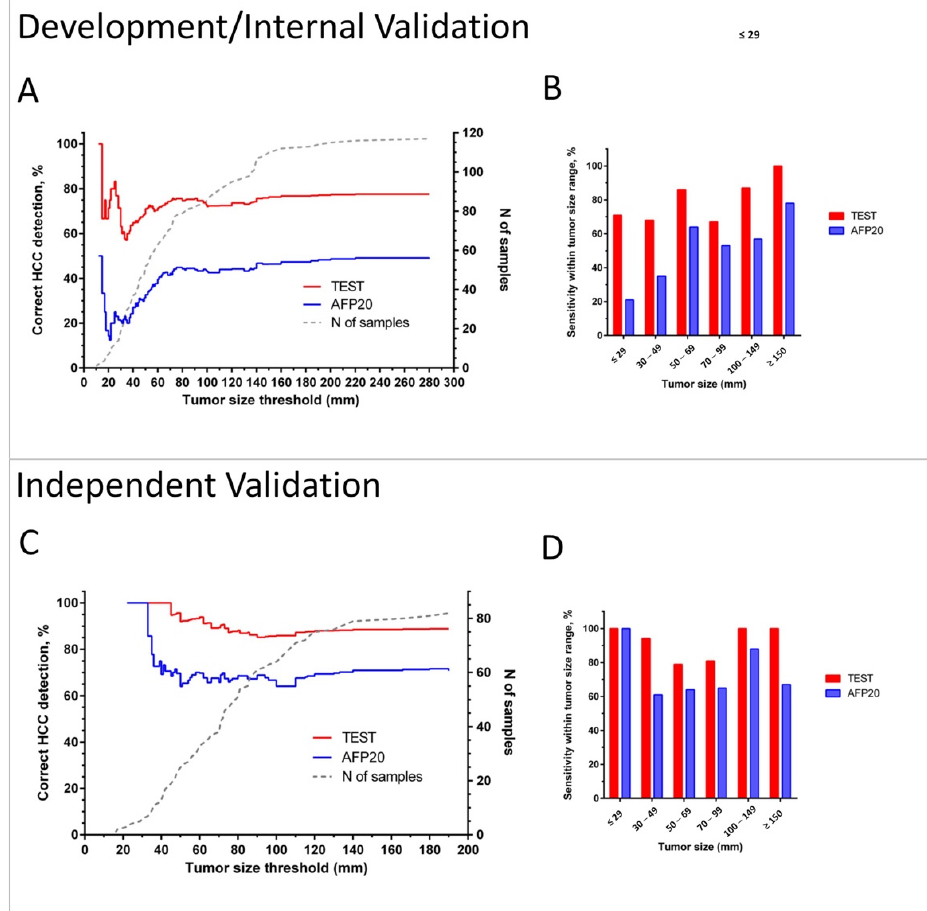
Figure 5. Sensitivity of HCC detection by the test and by AFP using cut-off 20 ng/mL (AFP20) in cancer patients. Plots A and C show in red (Test) and blue (AFP20) lines % of correct identifications of HCC for patients with tumors up to the threshold tumor size in the combined Development/Internal Validation set ( A ) and in the Independent Validation set ( C ). Dotted grey line (corresponding to the right Y-axis) shows the number of patients with tumors up to the threshold size. Bar charts B and D show sensitivity within the selected tumor size ranges in the Development/Internal Validation set ( B ) and in the Independent Validation set ( D ).